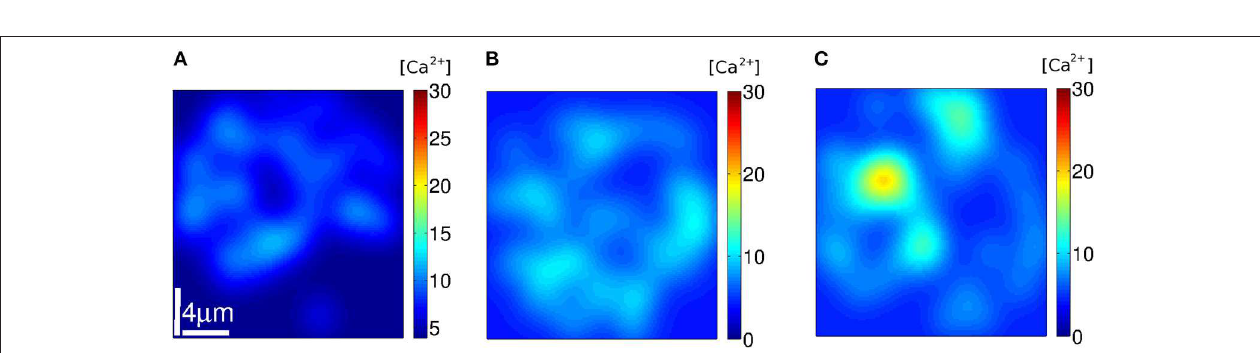
9, (B) to 49 and (C) to 215. =